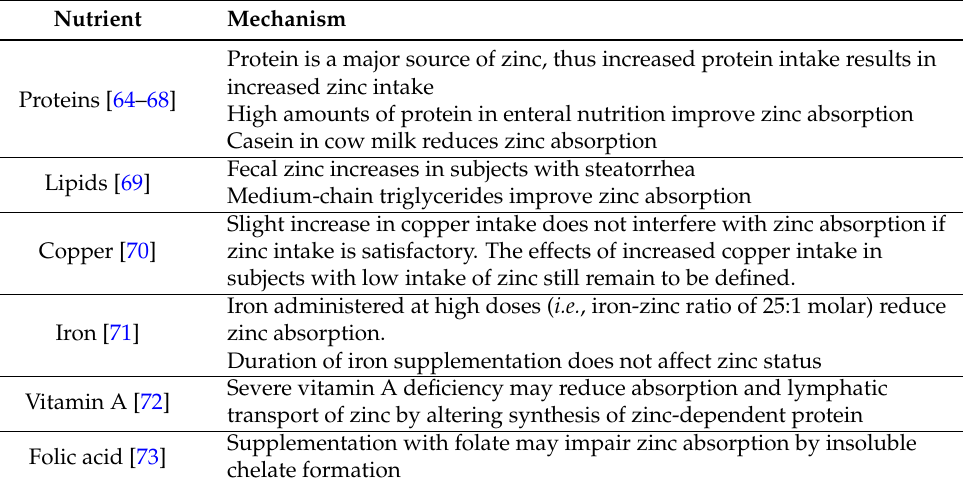
Table 4. Mechanisms of the influence of other nutrients on zinc